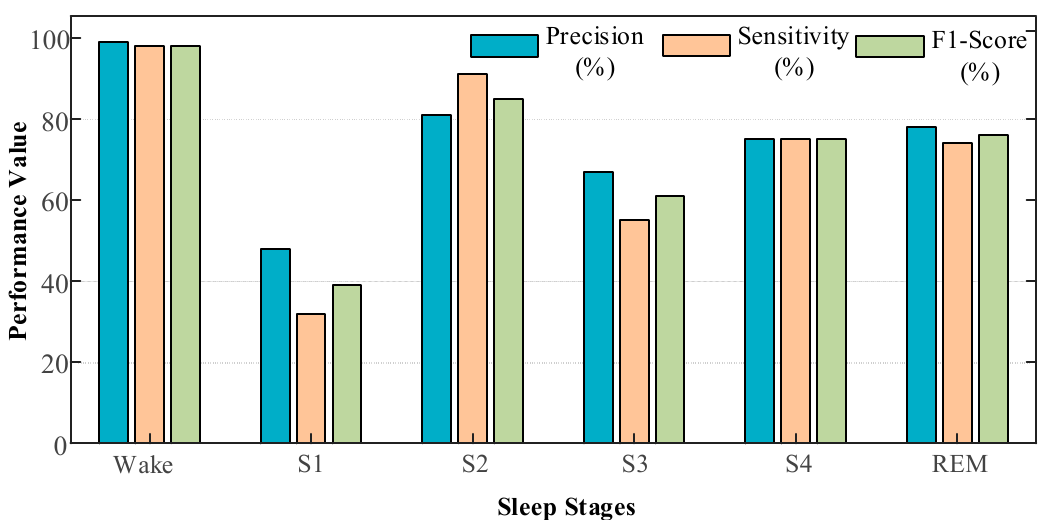
Figure 12. Graphs of performance measures for the six-class model during the testing phase with single-channel EEG signals obtained from the sleep-edfx database.